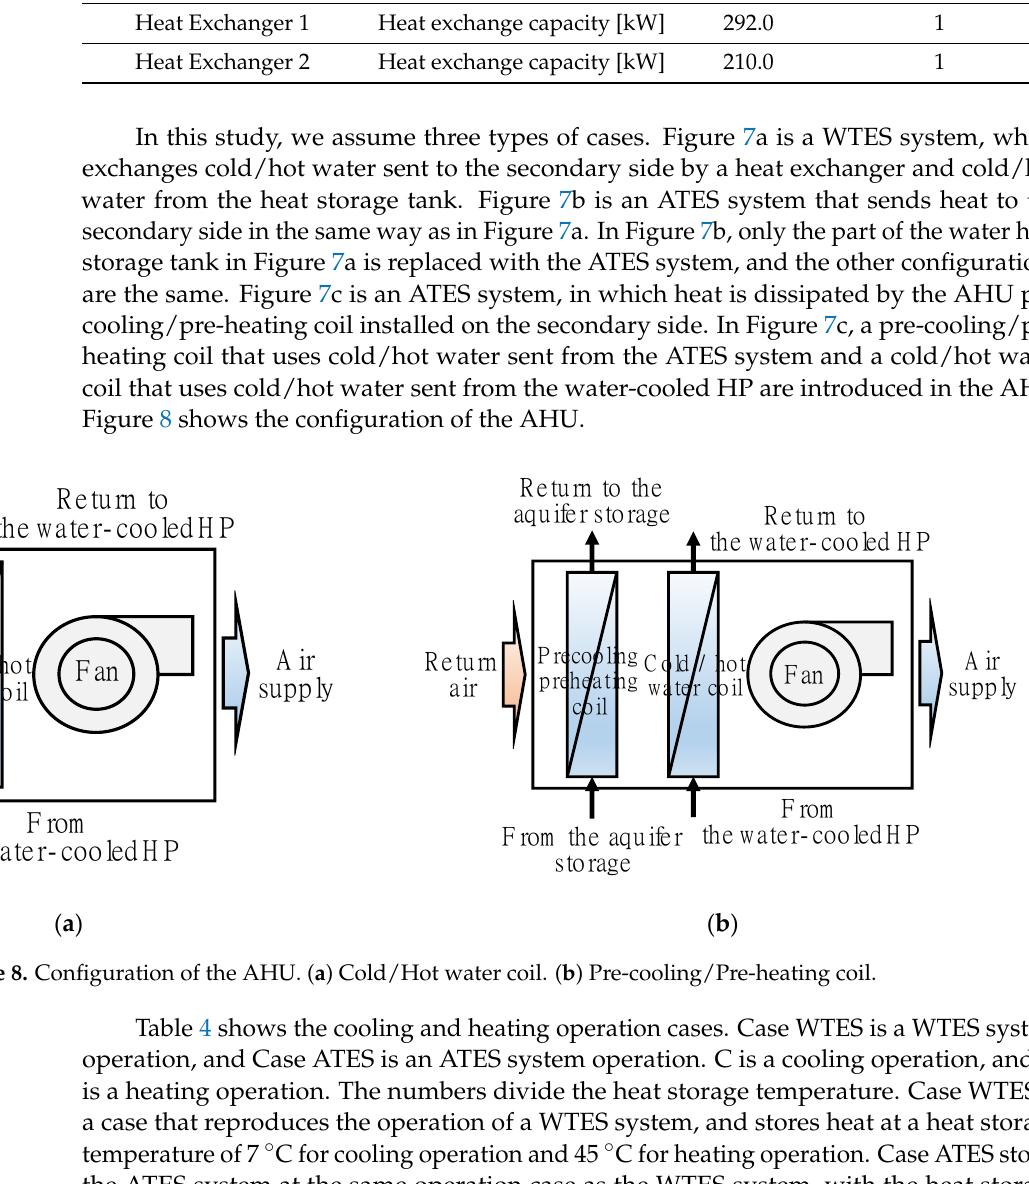
Table 3. The rated capacity of the heat source equipment.